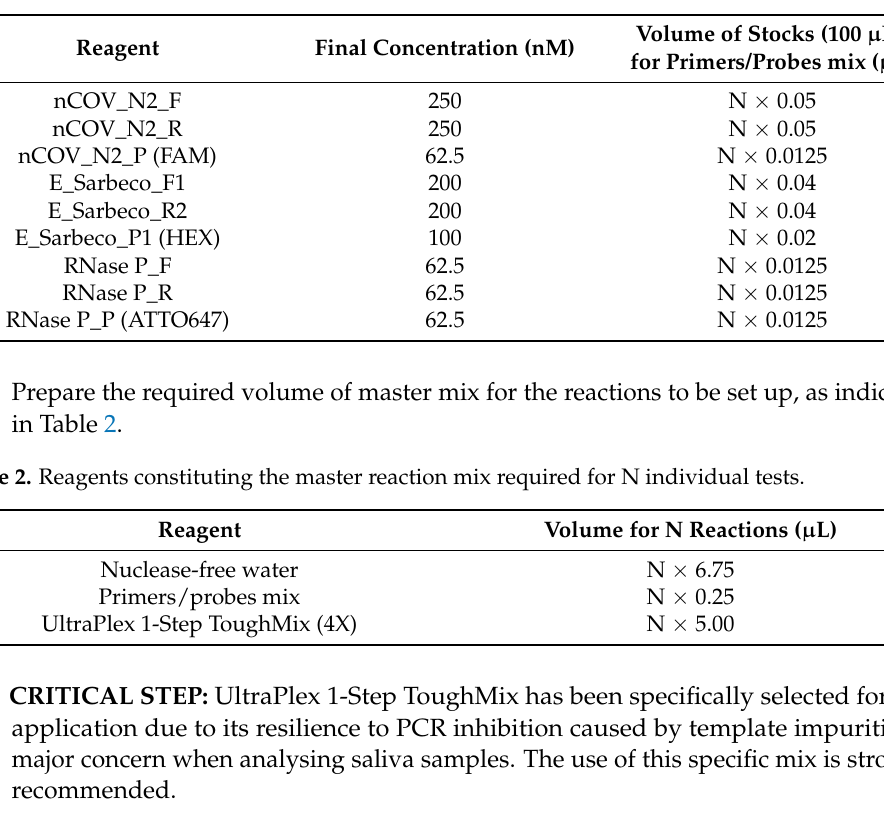
Table 1. Primers and probes required in the reaction mix. The final concentration of each reagent is indicated. A primers/probes mix for N reactions can